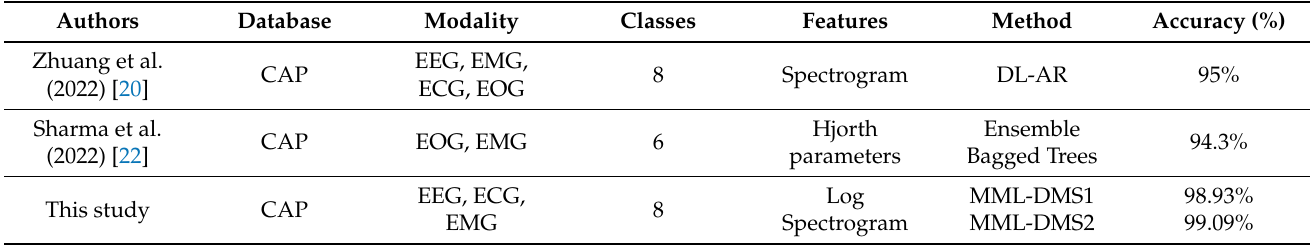
Table 8. A comparison with related multimodal sleep disorder classification